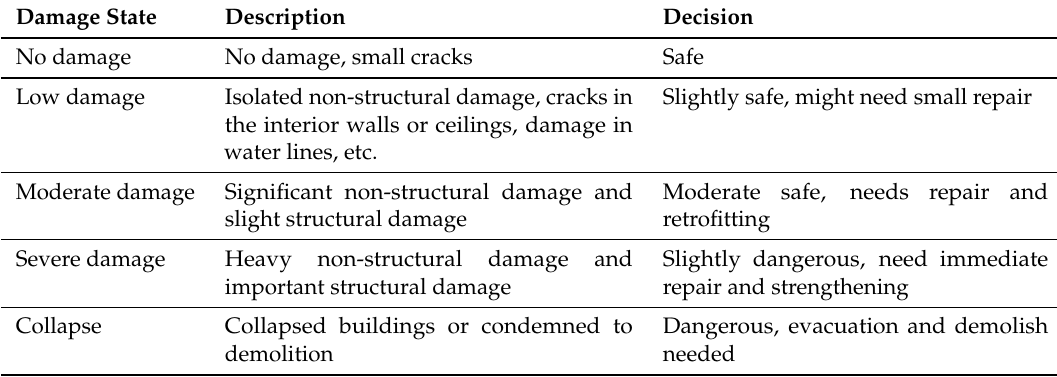
Table 3. Description of damage levels and recommended decision (adopted from